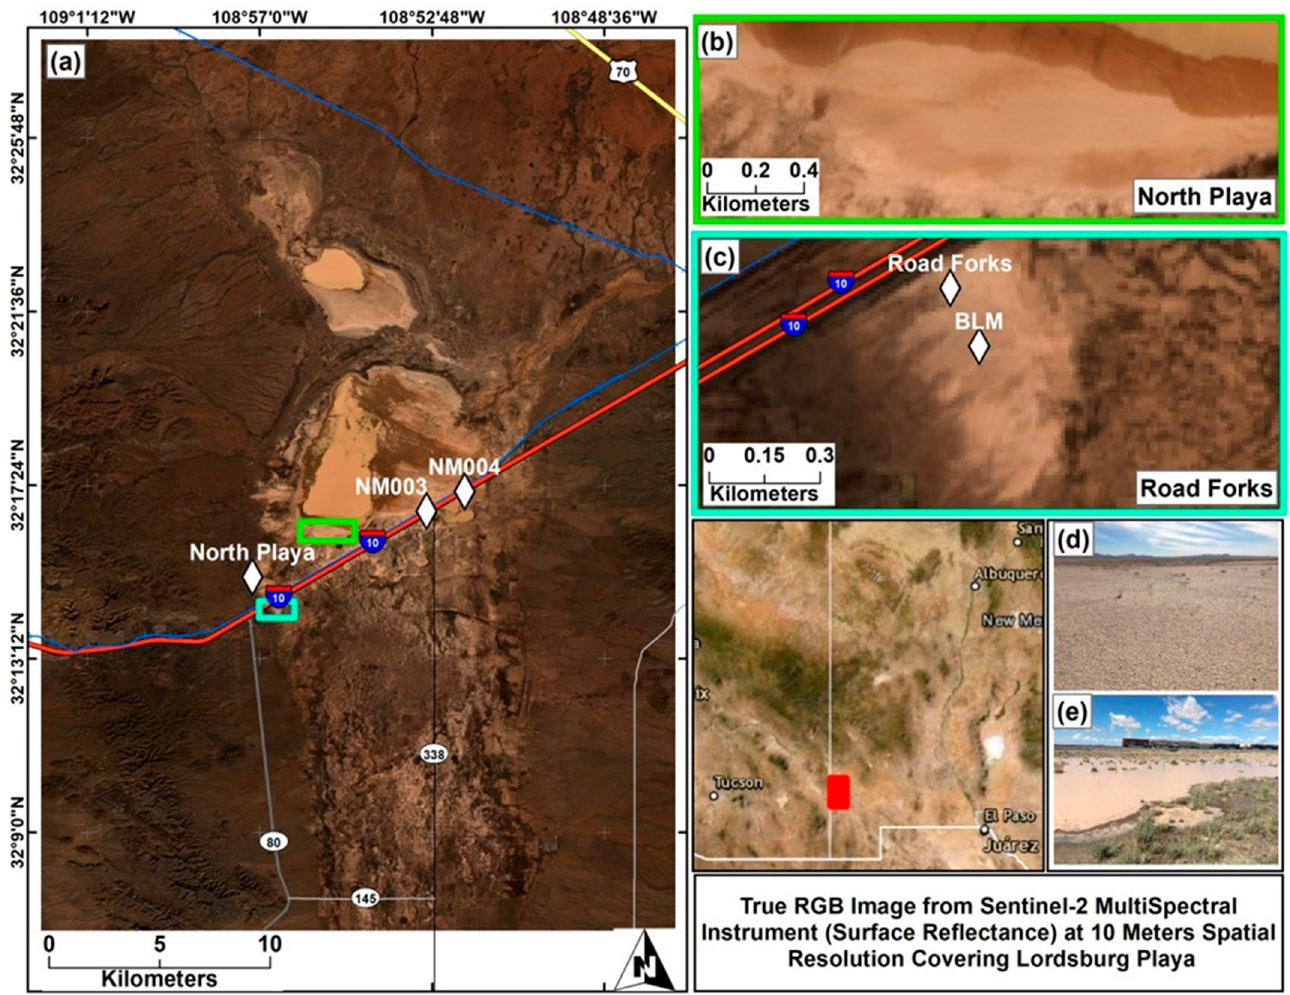
Figure 2. ( a ) True RGB (Band 4—Red, Band 3—Green, and Band 2—Blue) image of the study area covering Lordsburg Playa from Sentinel-2 MSI (MultiSpectral Instrument) Level 2A at a 10-m spatial resolution [58]. The North Playa Field is bounded by the green rectangle, and the Road Forks Playa Field is bounded by the blue-green rectangle. ( b ) North Playa field, used to simulate soil loss using the SWEEP model. ( c ) Road Forks field, used to simulate soil loss using the SWEEP model. ( d ) Example of hard crusted surface from the inner part of the playa on 7 March 2018. ( e ) Inundated area on the playa, adjacent to the highway and railroad, on 20 September